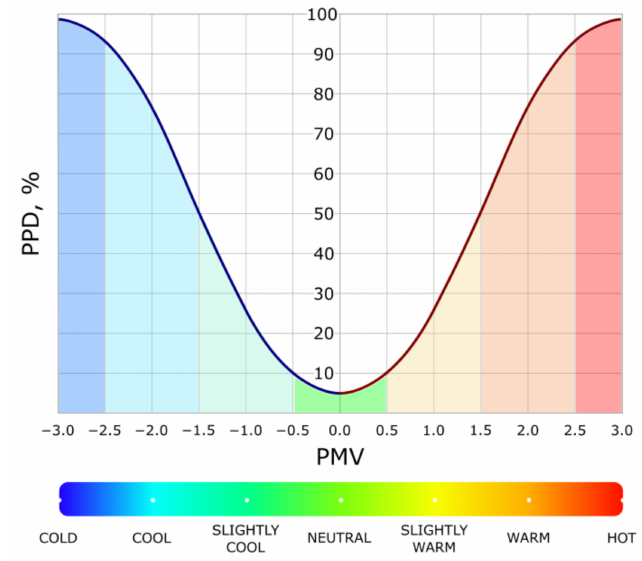
Figure 1. Graphical interpretation of the relationship between PMV and